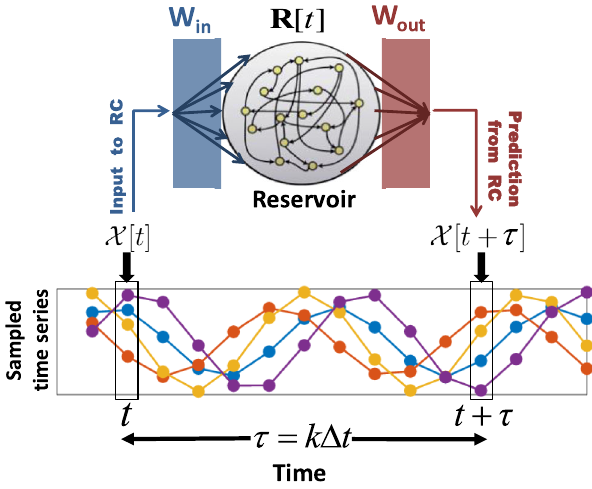
FIG. 1. Schematics of the RC trained for predicting the time series k time steps ahead. Lower: the four time series represent scalar components of X ½ t (cid:2)